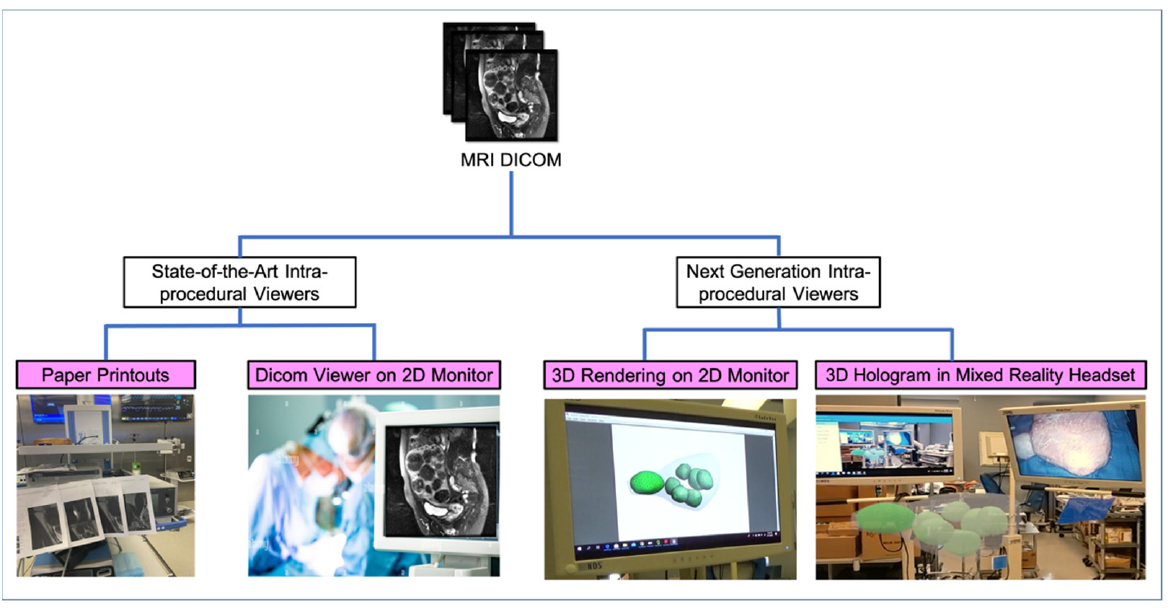
Figure 1. Overview of intra-procedural MRI viewers. From left to right is the relative order of low tech to high tech methods for viewing MRI DICOMs during a procedure.